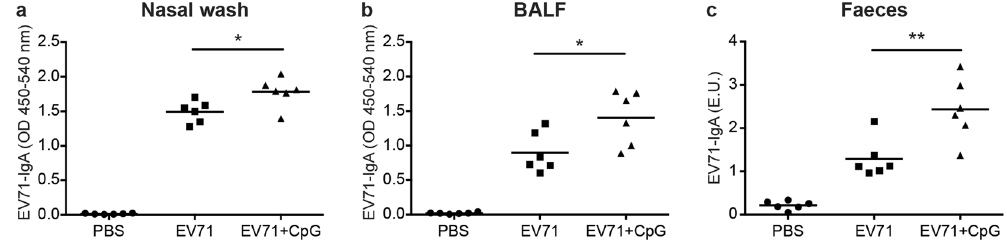
Figure 2. EV71-specific IgA titres in nasal wash, BALF, and faeces. Mice were intranasally immunised with PBS, formalin-inactivated EV71 (5 μ g/dose), or formalin-inactivated EV71 (5 μ g/dose) plus CpG (20 μ g/dose) three times at 3-week intervals. ELISA was used to measure EV71-specific IgA in the nasal wash ( a ), BALF ( b ), and faeces ( c ) of mice at 2 weeks after the third immunisation. Values shown are means ± SEMs of six mice in each experimental group; * p < 0.05, ** p < 0.01. One representative study of three with similar results is shown. BALF: bronchoalveolar lavage fluid.